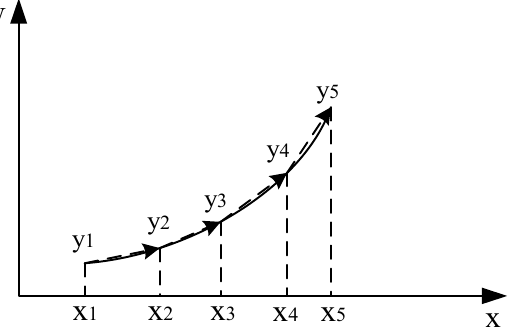
Figure 3. Schematic diagram of piecewise linearization. In the figure, the curve described by the dotted line represents the original nonlinear curve; “(X1,y1)-(X5,y5)” represents several coordinate points on the original nonlinear curve; the lines with arrows represent the differential lines for incremental piecewise linearization of the original curve.